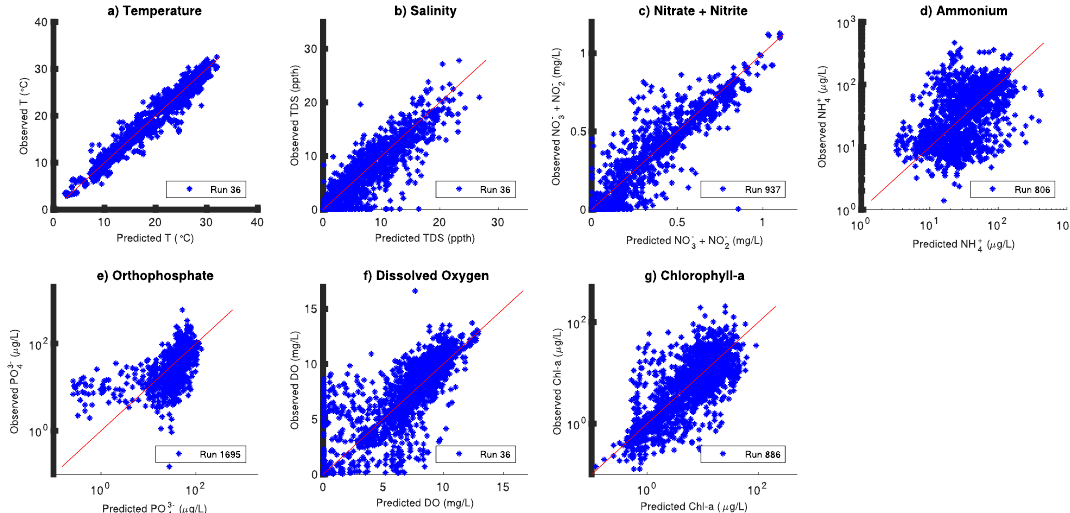
Figure 5. Predicted versus observed scatter plots for hydrodynamic and water quality parameters for 1998–2000. The predicted = observed line is shown in red. Panels show (a) temperature, (b) salinity, (c) nitrate + nitrite, (d) ammonium, (e) orthophosphate, (f) dissolved oxygen, and (g) chlorophyll-a